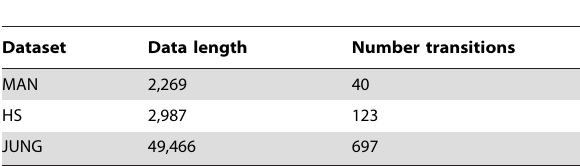
Table 1. Data, data length, and found number of transitions.